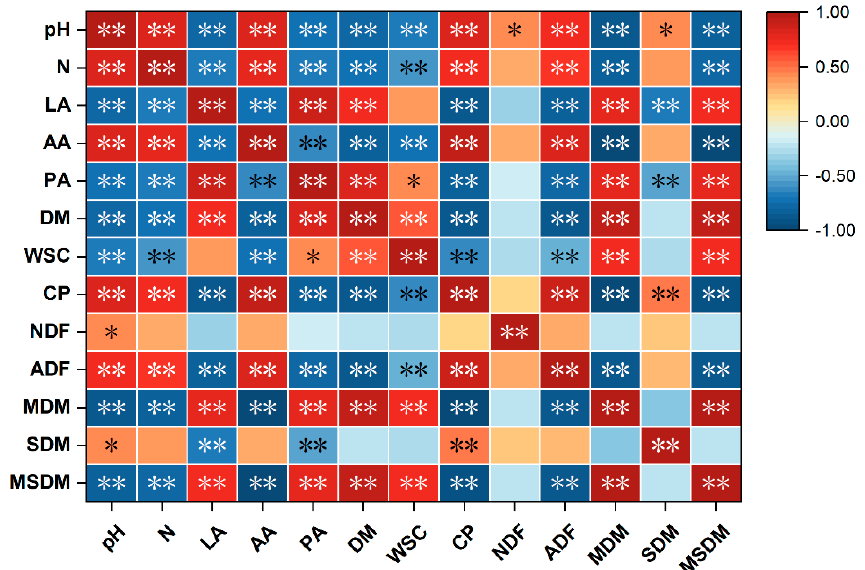
Figure 3. Correlation analysis between field treatments and silage quality. LA, Lactic acid content; AA, acetic acid content; PA, propionic acid content; N, NH 3 -N/TN; DM, dry matter content; CP, crude protein; WSC, water-soluble carbohydrates; NDF, neutral detergent fiber; ADF, acid detergent fiber; MDM maize dry matter yield; SDM, soybean dry matter yield; MSDM, maize and soybean dry matter yield. The corresponding values of the heatmap are the Pearson correlation coefficient r ( − 1 to 1), with a value below 0 representing a negative correlation ( blue ) and a value over 0 representing a positive correlation ( red ). “*” and “**” represent the relation between indices are significant at %5 and 1% level, respectively.